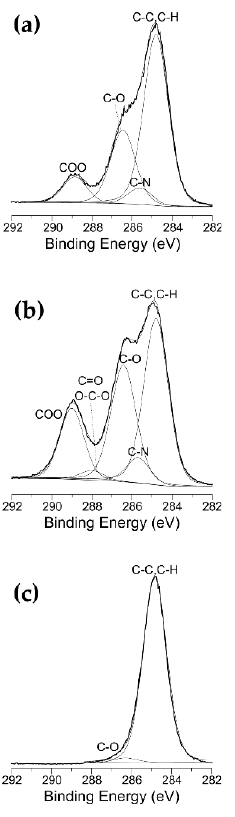
-- Table 2. Curve fitting results of C 1s XPS spectra of the pristine PU foam, the foam after step 1 (t